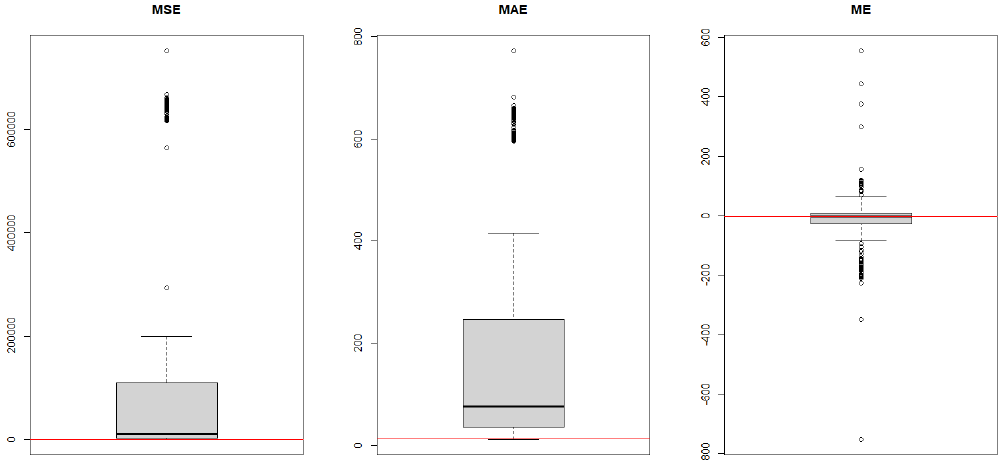
Figure A1. Box plots displaying the MSE, MAE and ME of 300 fully trained neural networks using different hyperparameters. MSE, MAE and ME evaluated with respect to the (Sobol) validation set. Figures of the ensemble of 10 best performing neural networks added in red.